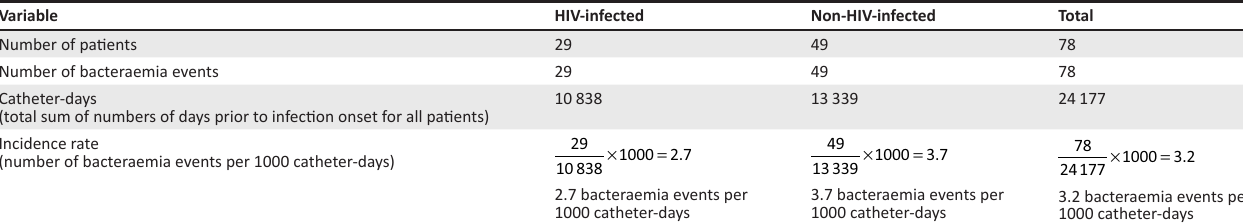
TABLE 3: Incidence of bacteraemia. Variable